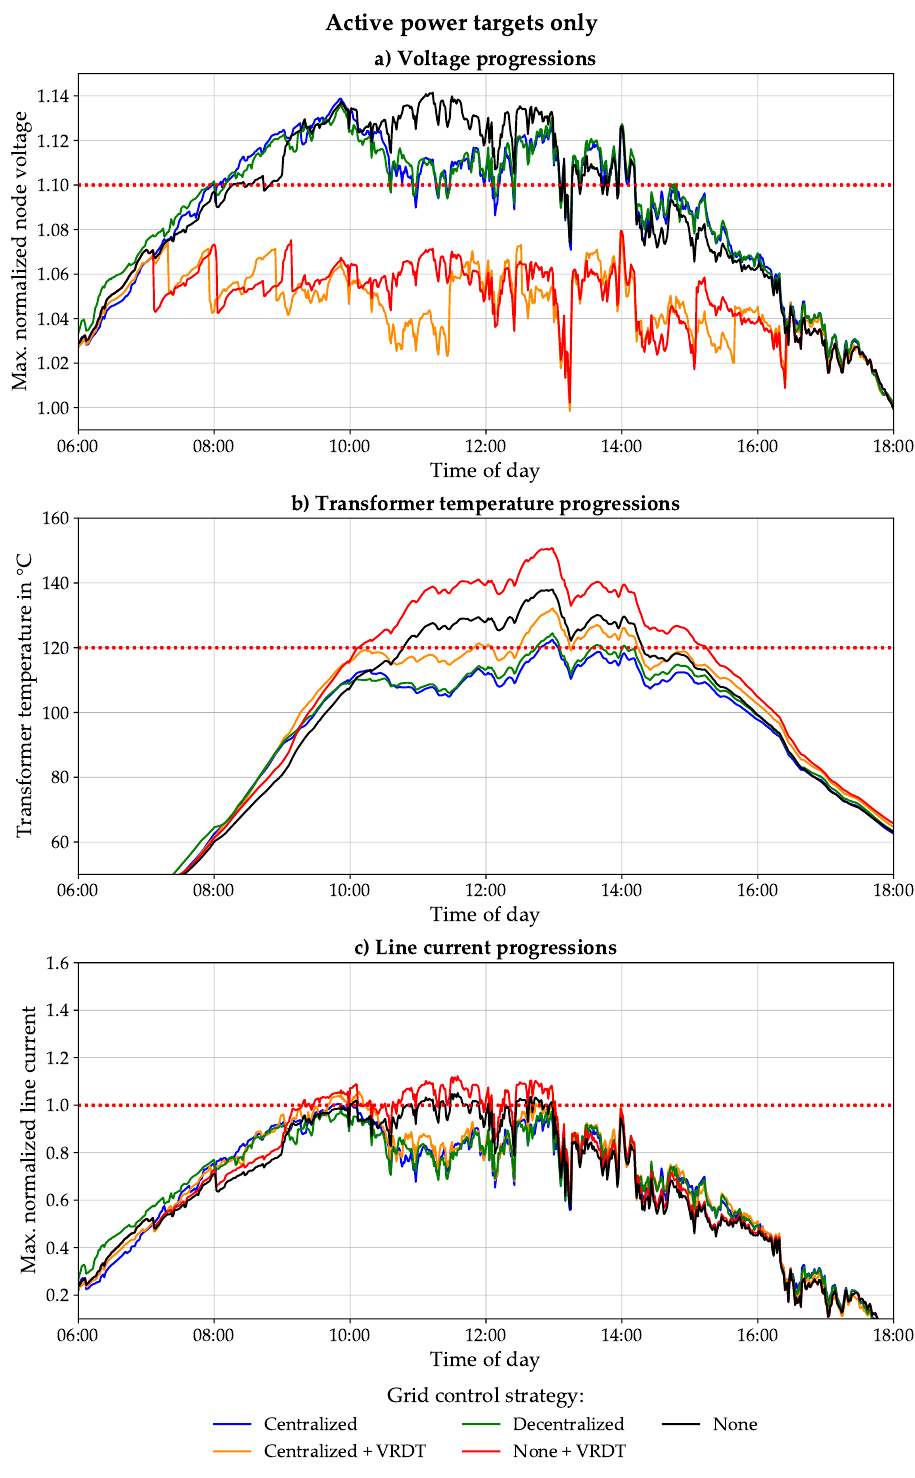
Figure 7. Performance comparison of the centralized and decentralized grid control strategies. Here, only active power targets are used. Grid status progressions without flexibility-based grid control are given as a reference. The simulated day is 1 July. For comparability, all displayed progressions are based on the same random seeds. Maximum admissible values are indicated by red, dotted lines. ( a ) shows the progressions of the maximum node voltage in the grid. ( b ) shows the progressions of the transformer temperature. ( c ) shows the progressions of the maximum line current in the